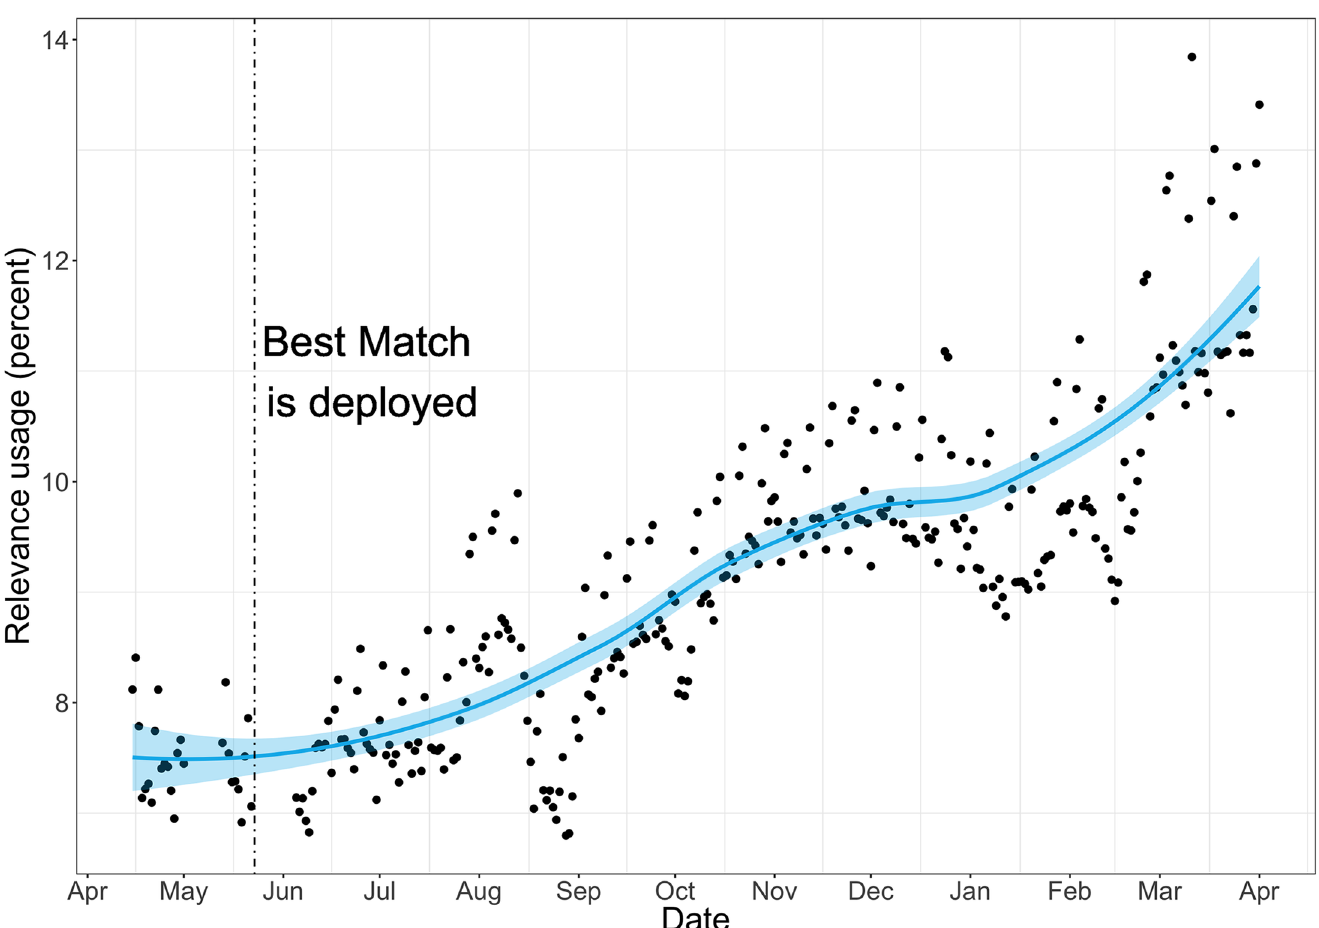
Fig 3. Usage rate of relevance sort order over 6 months (May 2017 to October 2017). The blue line represents the trend, and the blue area represents the variance. The vertical line denotes the switch to the new relevance algorithm, Best Match, which is followed by a significant and steady increase in usage. Note that the 1% usage rate on the y -axis represents about 30,000 queries on an average work